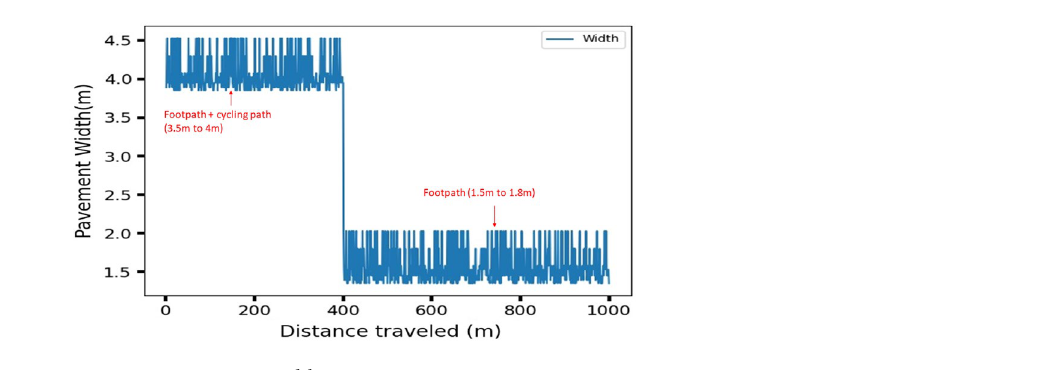
Figure 30. Pavement width